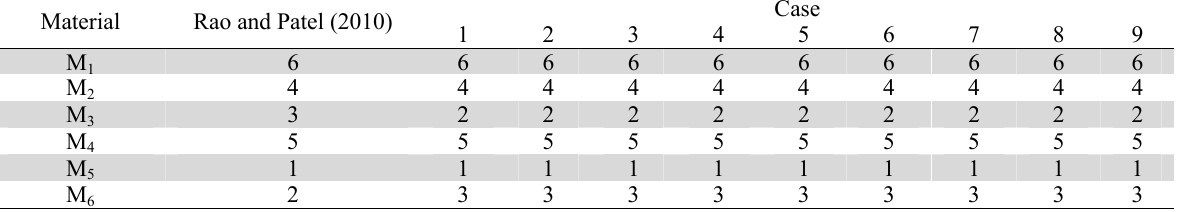
Rankings of high speed naval craft materials using TOPSIS method Material Rao and Patel (2010)